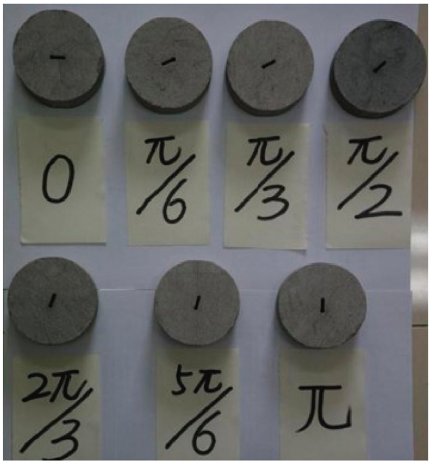
Figure 3: Schematic view of CSCFBD specimens with different inclination angles of